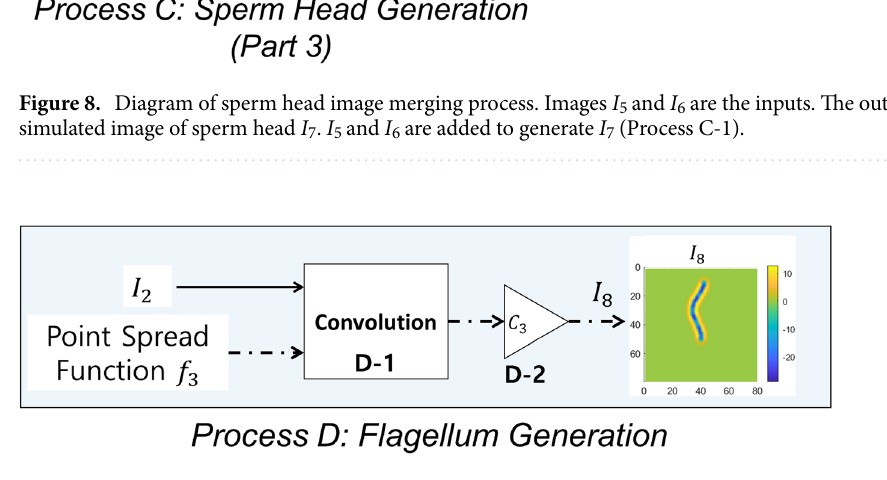
Figure 9. Flowchart of flagellum generation process. Image I 2 and point spread function f 3 are the inputs. The output is the simulated image of flagellum I 7 . I 2 and f 3 are convolved and then scaled by C 3 to generate I 7 (Processes D-1 and